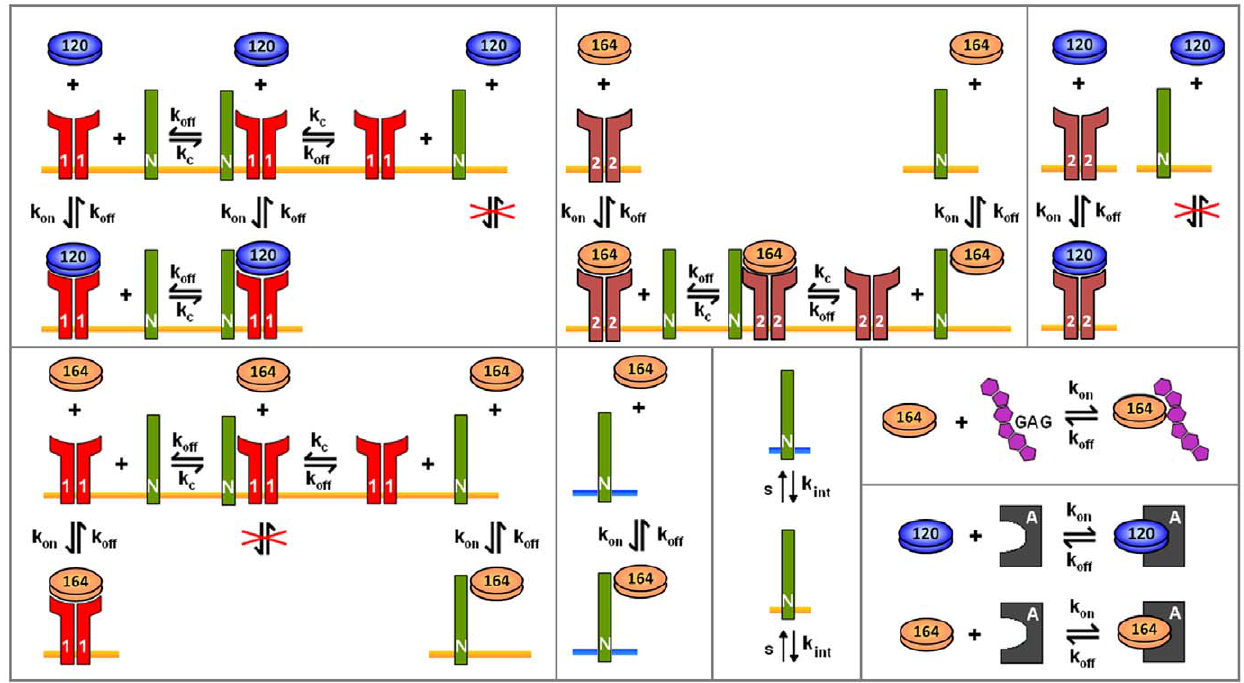
Figure 2. Molecular interactions. The binding interactions of VEGF 120 and VEGF 164 are different. VEGF- 120 binds to VEGFR-1 and VEGFR-2 but not to NRP-1. VEGF 164 binds to VEGFR-1, VEGFR-2, NRP-1, and glycosaminoglycan (GAG) chains in the extracellular matrix. In simulations where the anti- VEGF agent (VEGF Trap) is added, both isoforms bind to the anti-VEGF agent to form a complex. Binding and unbinding of VEGF to receptors are denoted as k on and k off , respectively. k c denotes the coupling of NRP-1 and VEGFR-1 and of NRP-1 to VEGFR-2. While only the internalization of NRP-1 is shown, all VEGF receptors and complexes can be internalized at a rate k int . Similarly, while only the insertion of NRP-1 is shown, VEGFR-1 and VEGFR-2 also appear via insertion at a rate s . The blue bar is used to distinguish NRP-1 expressed on the myocytes from NRP-1 on the endothelial cells (orange bars).